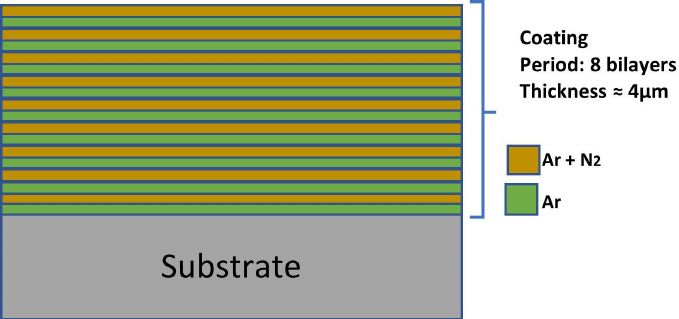
Figure 3. Diagram of the proposed bilayers that made up the deposited coatings.